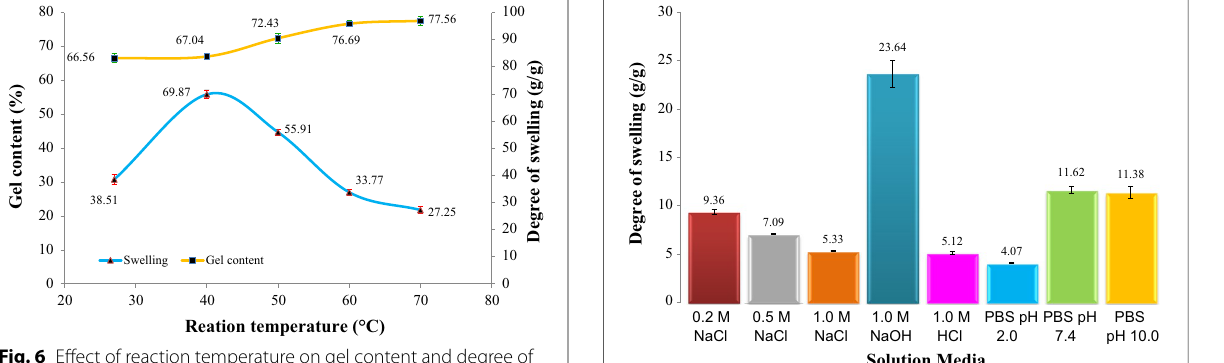
Fig. 6 Effect of reaction temperature on gel content and degree of swelling of CMSS–acid hydrogel Fig. 7 Degree of swelling of CMSS–acid hydrogel in different media